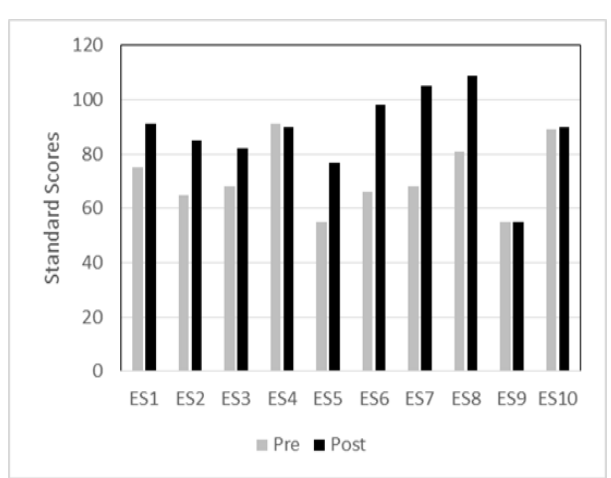
Figure 3. Individual standard scores of pre- and post- tests in the telepractice group.